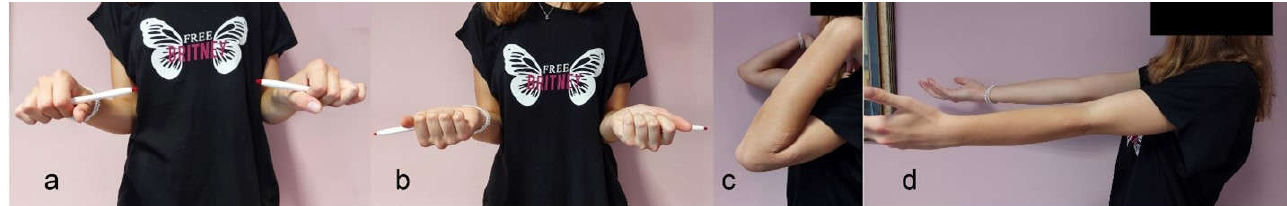
Figure 3. Thirteen years after reconstruction of the chronic Monteggia fracture. ( a ) Forearm prona- tion; ( b ) forearm supination; ( c ) elbow flexion and ( d ) elbow extension. ( b ) forearm supination; ( c ) elbow flexion and ( d ) elbow